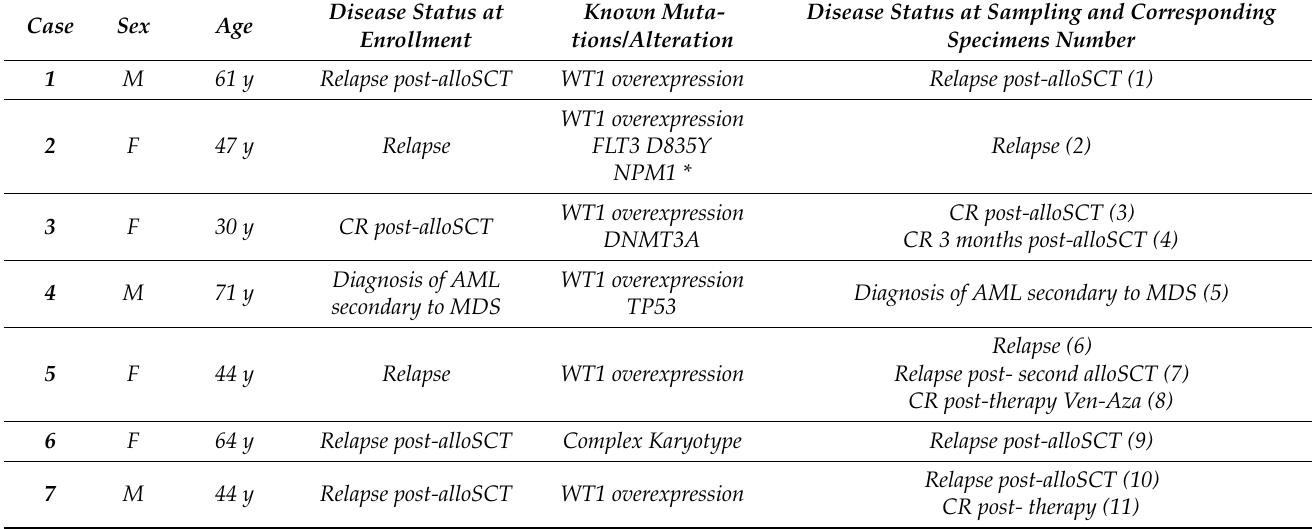
Table 1. Clinical characteristics of the enrolled AML cases and the disease status at the moment of each specimen. Bone Marrow (BM), Peripheral Blood (PB) and leukemia-derived exosomes were analyzed for specimens 1–31. PB and leukemia-derived exosomes were analyzed for samples 32–34. * Mutations detected only at